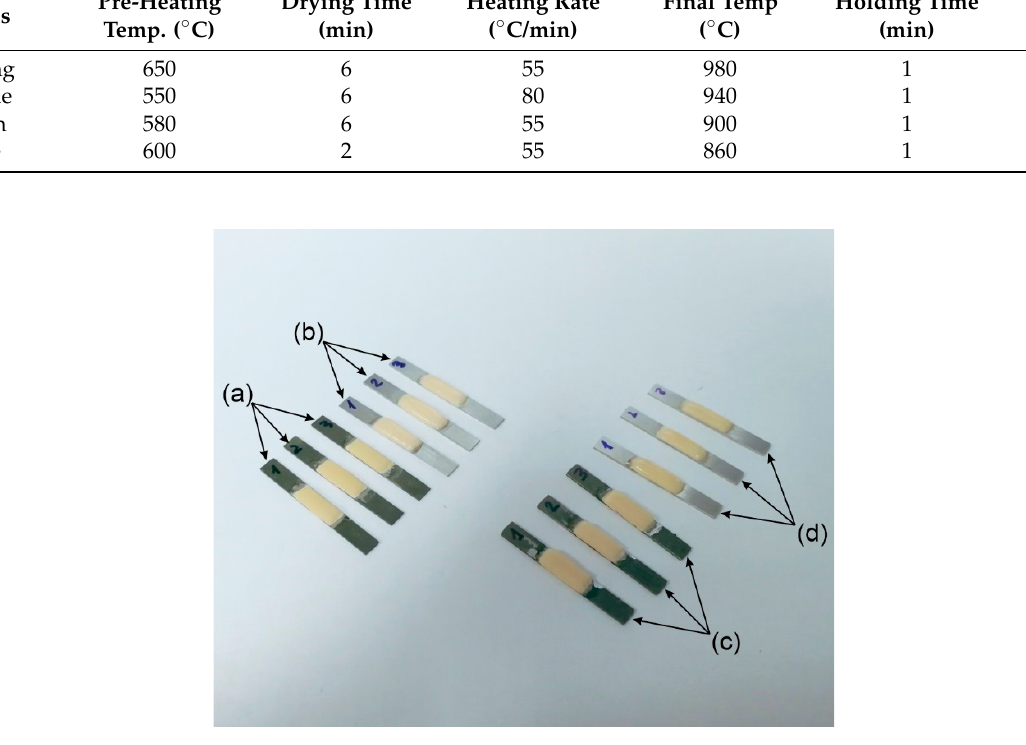
Figure 4. Sample of adhesion specimens of ceramic-veneered ( a , c ) and composite-veneered ( b , d ) milling disc ( a , b ) and LDED ( c , d ). Table 2. Summary of the feldspathic veneering method parameters used in this study.